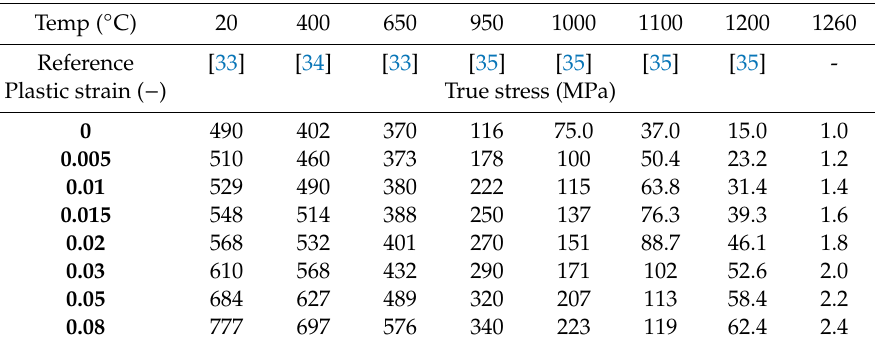
Table 2. Flow stress of alloy